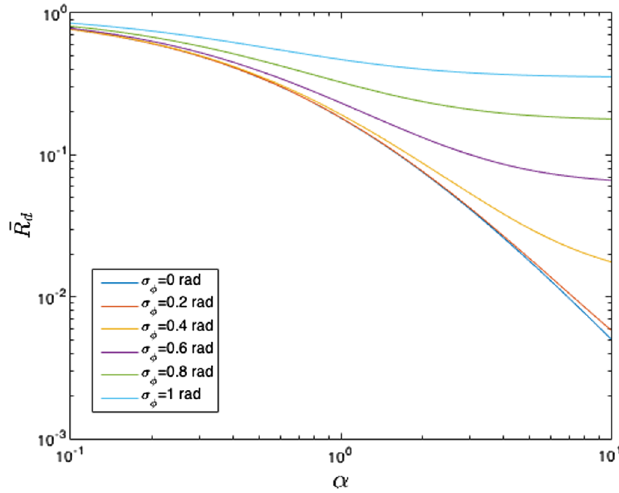
.FIG. 8. Damper correction factor as a function of α and tune